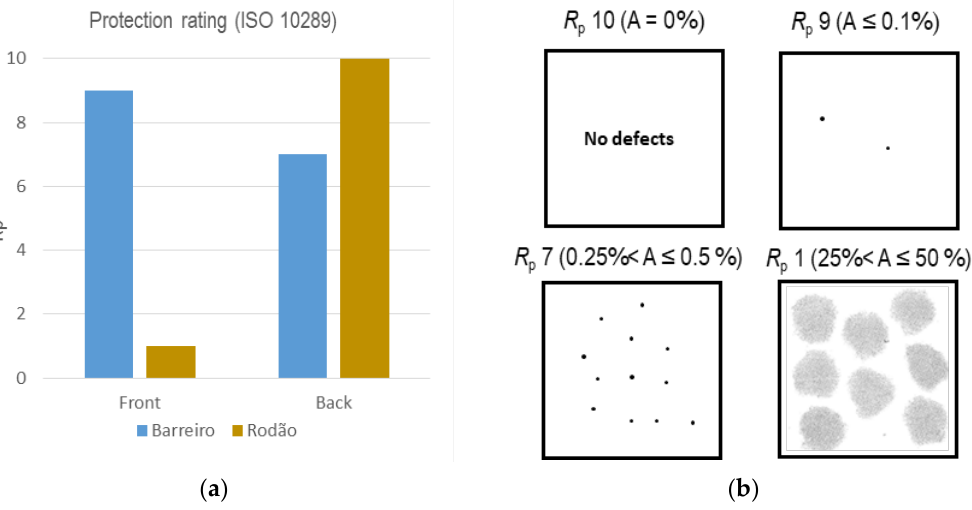
Figure 5. Evaluation of anodic coating protection performances after 10 years’ exposure at both test sites: ( a ) average (considering all thickness ranges) protection ratings, R p ; ( b ) correspondent standard corrosion-affected areas and dot charts used ( scale: 1:2).